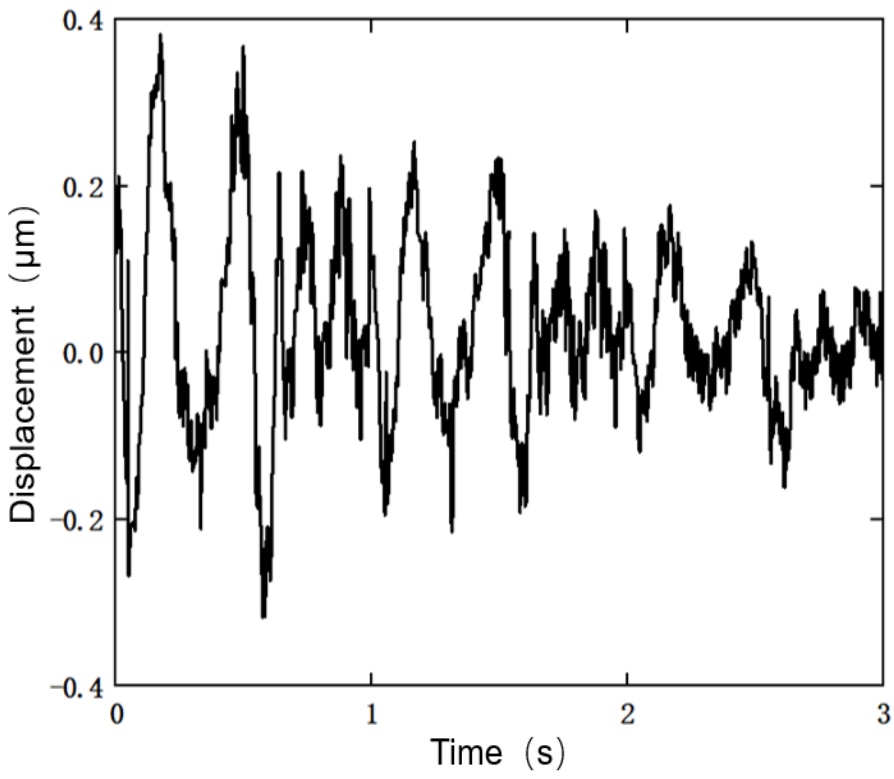
Figure 23. Displacement error diagram of x direction variable-amplitude signal.